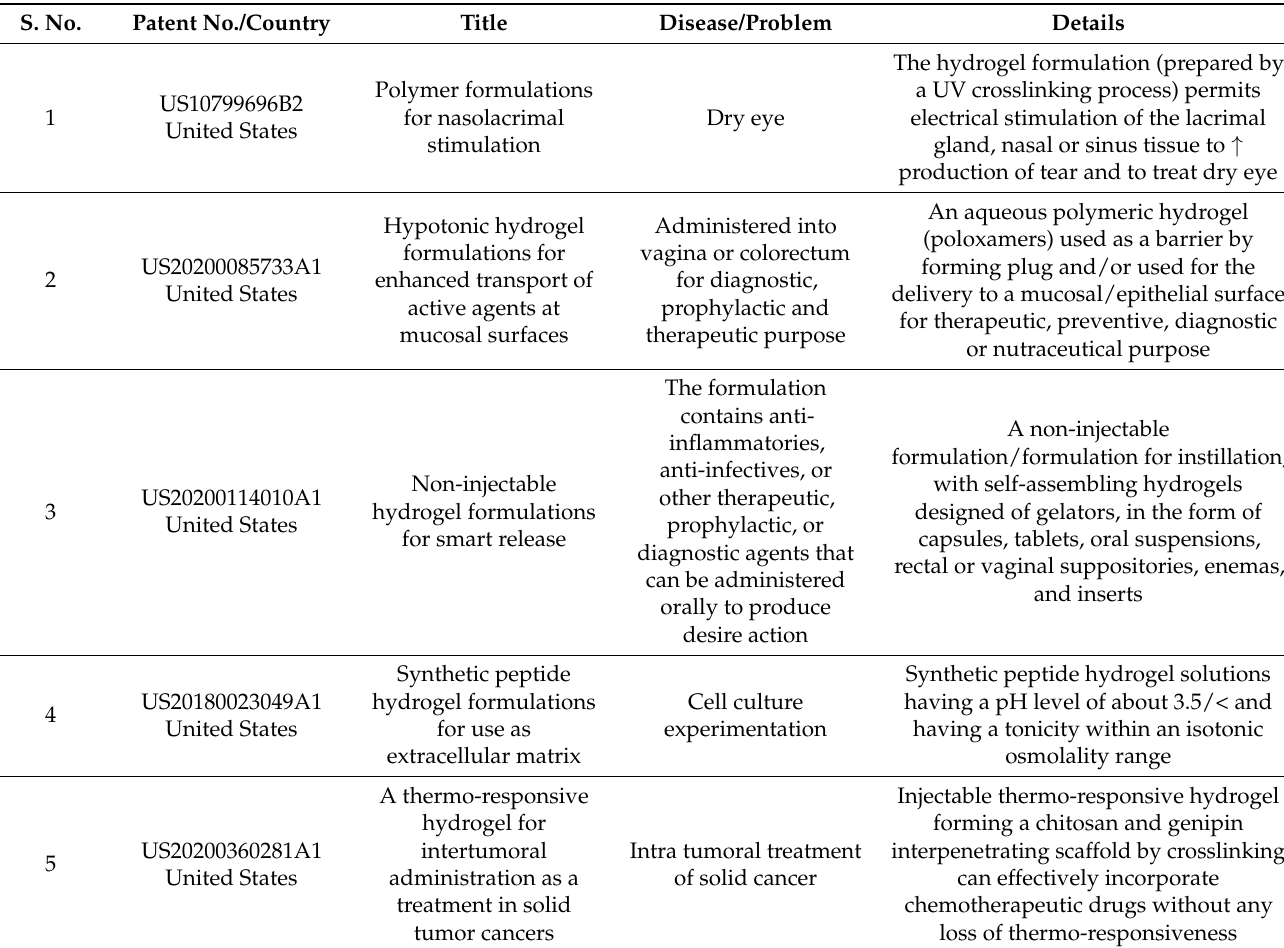
Figure 5. Possible biomedical applications of hydrogel. Table 2. List of Patent for various hydrogel